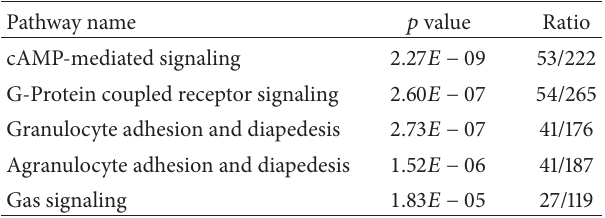
Table 5: Canonical signaling pathway by SEME6D high expression.